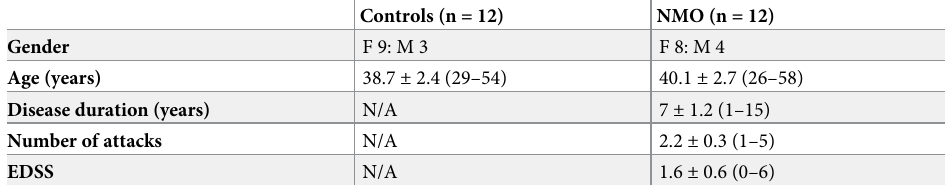
Table 1. Clinical neurological data of neuromyelitis optica (NMO) patients and age-matched